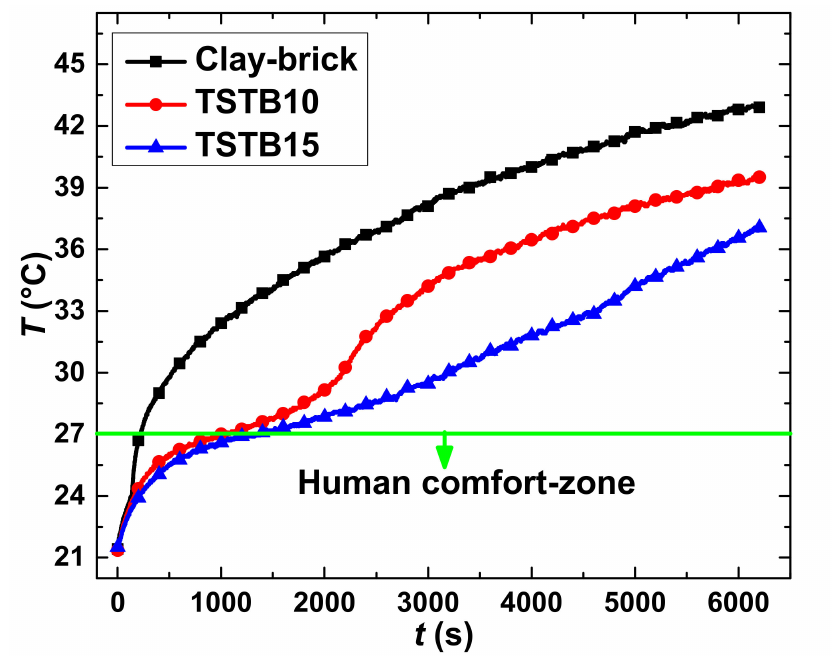
Figure 6. Thermal analysis of clay-brick and